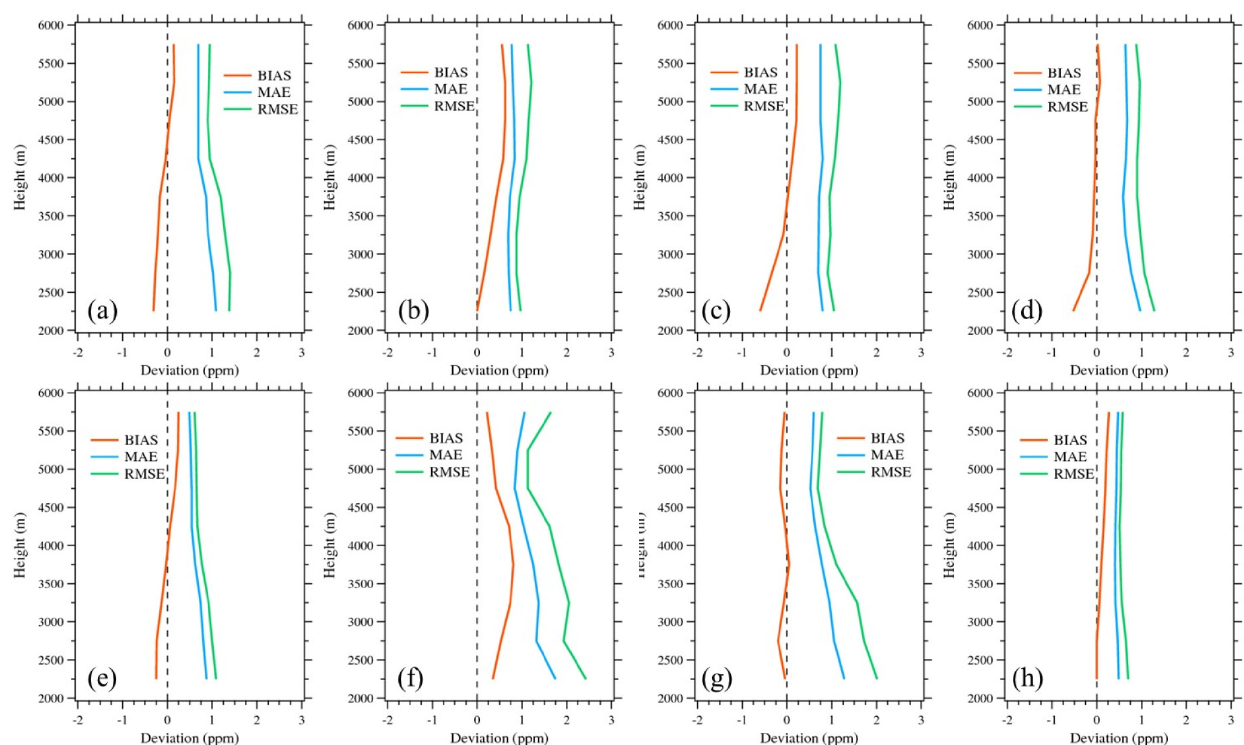
Figure 11. Statistical results for monthly mean profiles in the eight Asia-Pacific cities ( a Hong Kong, b Bangkok, c Singapore, d Jakarta, d Tokyo, f Shanghai, g New Delhi, and h Sydney).